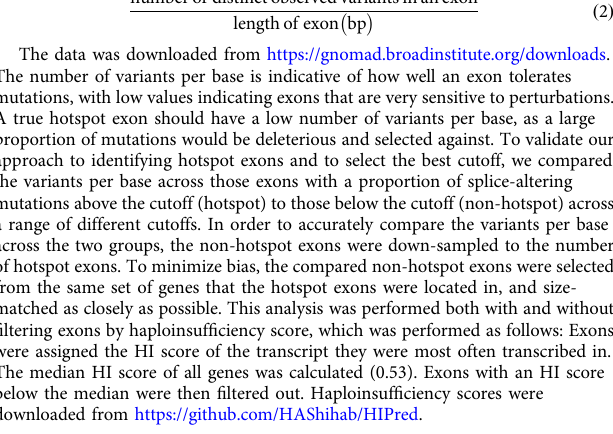
( Table S1 ) . The ‘ gbm ’ R package with the following parameters was used to train the model: distribution: Bernoulli, number of trees: 1000, learning rate: 0.05, interaction depth: 3, bag fraction: 0.5, minimum number of observations in a node: 10, cross- validation folds: 3. The additional Random Forest model was trained using the “ randomForest ” R package with default parameters. 70% of the variants were used for training and the remaining 30% for evaluation. All in-house source code for